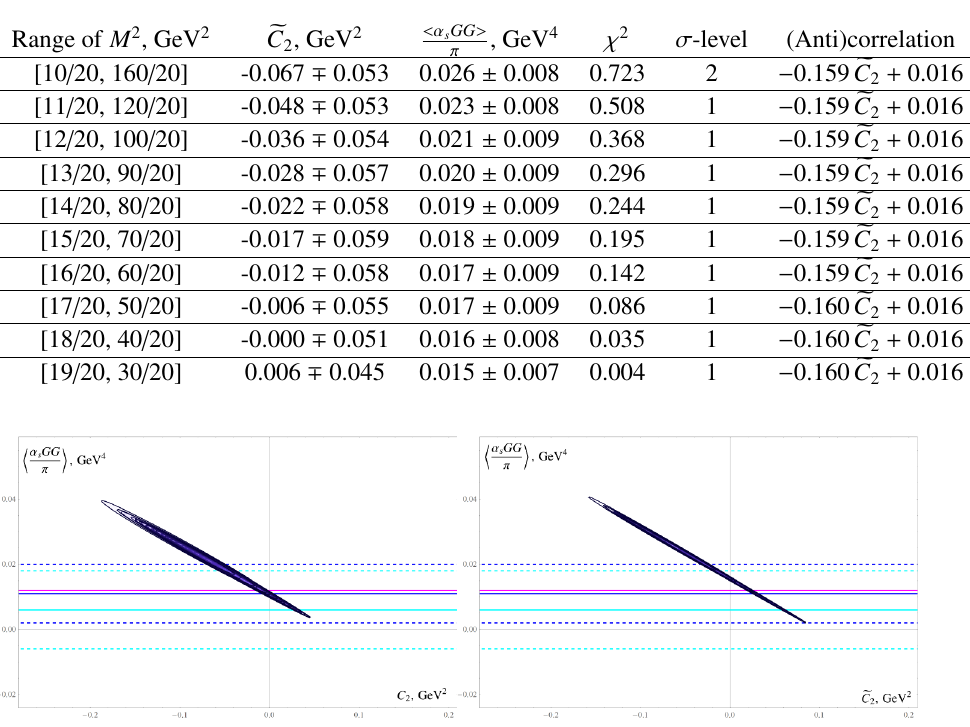
Table 4. The fitting results for di ff erent intervals of M 2 in APT with Λ = 0 . 25 GeV. In the fifth column the σ -level where (cid:101) C 2 = 0 is shown. In the sixth column the (anti)correlation between the gluon condensate and (cid:101) C 2 is shown